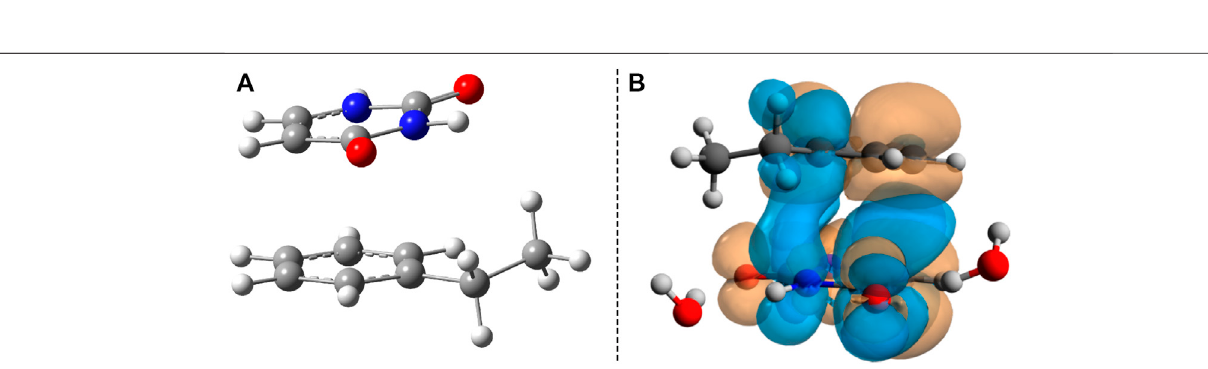
FIGURE 4 | The Natural Difference Orbitals (orange (cid:1) hole and blue (cid:1) electron) computed for the fi rst three low-lying excited states of the benzene – uracil (B – U) complex using the TD- ω B97X-D3/ma-def2-TZVPP level of theory.